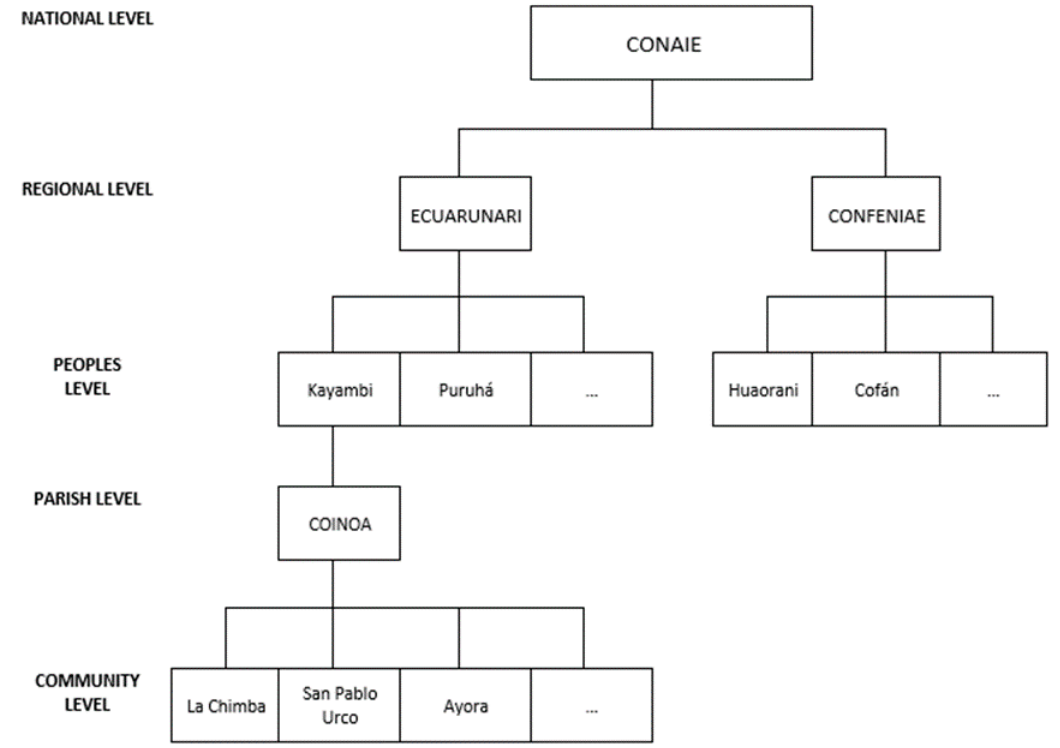
Figure 3. Levels of indigenous organisations in Ecuador.